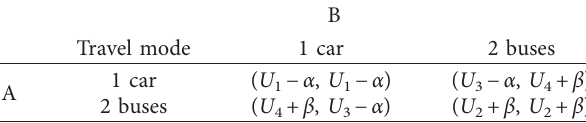
Table 3: Benefits matrix after limit